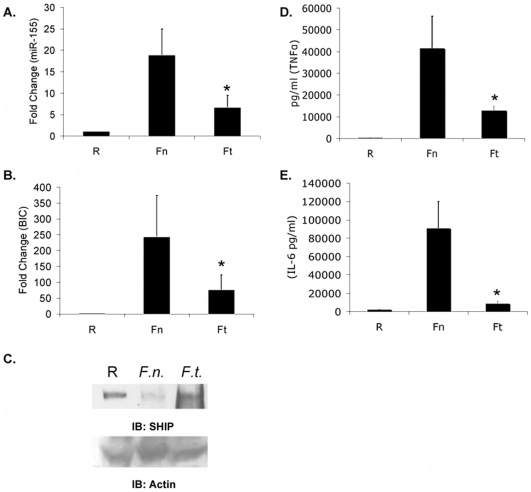
Virulent F.t. elicits suboptimal miR-155 and pro-inflammatory cytokine responses.(A–B) PBM (n = 7) were infected with F.n. or F.t. at an MOI of 100 for 24 hours. Relative miR-155 (A) and BIC (B) expression were measured by qRT-PCR. (C) PBM were infected with F.n. or F.t. at an MOI of 50 for 24 hours, then cell lysates probed for SHIP by Western blotting (top panel). The lower panel is a reprobe of the same membrane with anti-actin antibody. (D–E) PBM were infected with F.n. or F.t. at an MOI of 50 for 24 hours. TNFα (D) and (E) IL-6 in supernatants were measured by ELISA. Graphs represent the mean and standard deviation of samples from three independent infections. Data were analyzed by a paired Student t test. An asterisk (*) indicates a p-value<0.05.